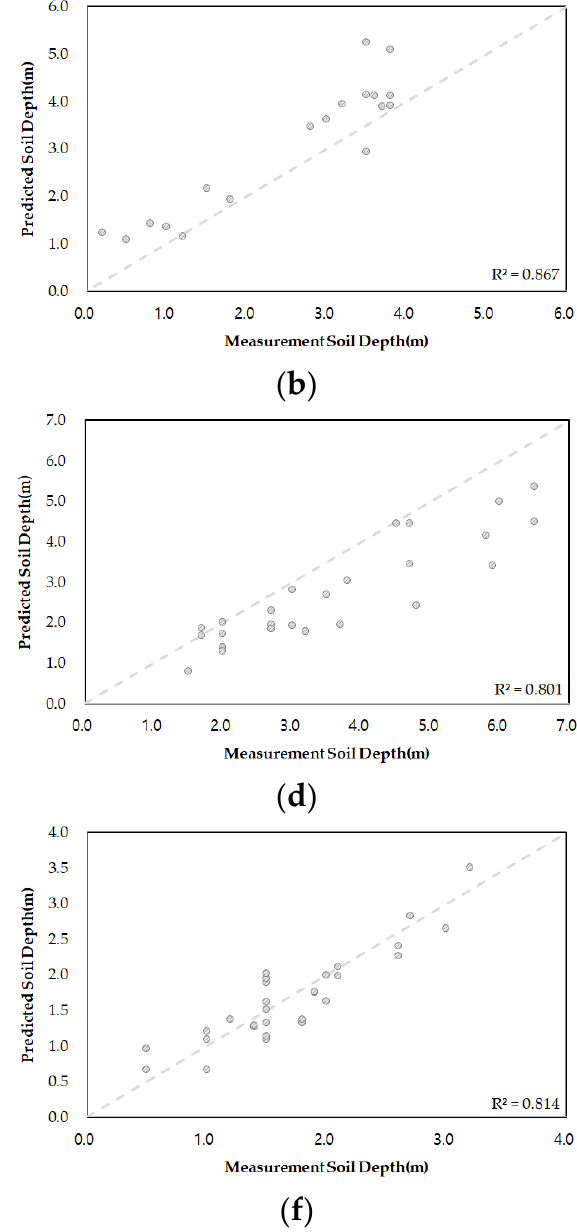
Figure 8 . The proposed statistical prediction models result in the verification sites, The soil depth map for ( a ) Igneous rock, ( c ) Metamorphic rock ( e ) Sedimentary rock, and Scatterplots showing the relationship between predicted and measured soil depth for ( b ) Igneous rock ( amorphic rock (